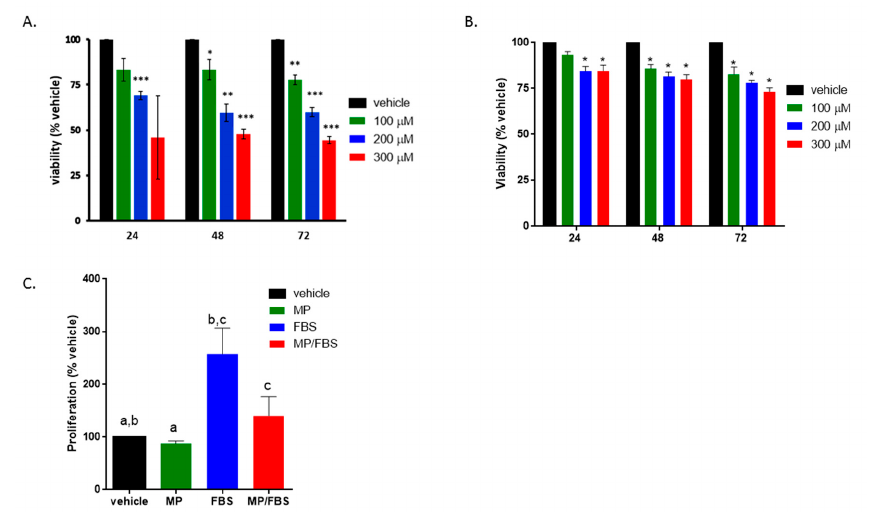
Figure 2. MP attenuates basal and (fetal bovine serum) FBS-induced vascular smooth muscle cells (VSMC) proliferation. Cells were treated with increasing concentrations of MP (100, 200, and 300 µ M) for 24, 48, and 72 h in the presence ( A ) or absence ( B ) of FBS. Cell viability was assessed by the overall metabolic activity measured by MTT. * p < 0.05, ** p < 0.01 and *** p < 0.005. Two-way ANOVA was performed. ( C ) Cells were grown in starvation or complete medium, in presence or absence of MP (100 µM). DNA synthesis was assessed BrdU incorporation assay. Values are calculated as % of the corresponding vehicle control value and represented as mean ± standard error of the mean (SEM) of three different experiments, each run in triplicate. Bars with same letters are statistically significant. One-way ANOVA followed by Tukey’s test was performed. Biomolecules 2019 , 9 , x FOR PEER REVIEW